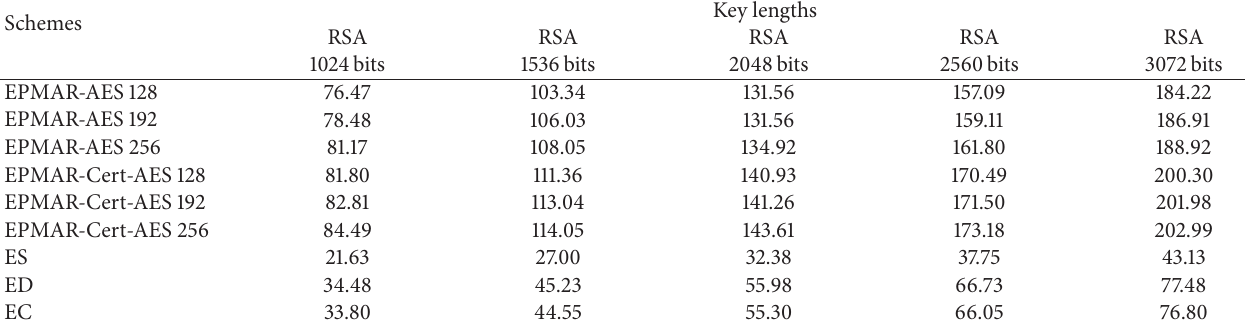
Table 7: Comparison of transmission time for an online transaction